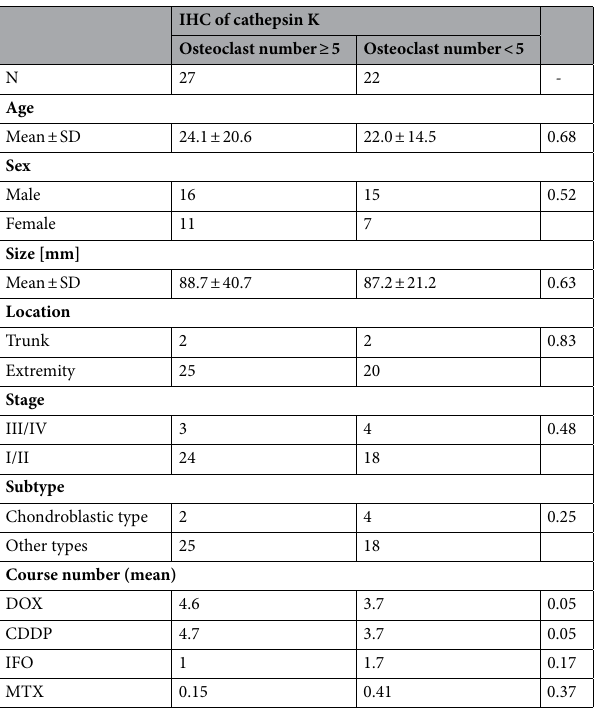
Table 5. Patients demographic data according to the number of osteoclast. DOX: doxorubicin, CDDP: cisplatin, IFO: ifosfamide, MTX: methotrexate, SD: standard deviation.